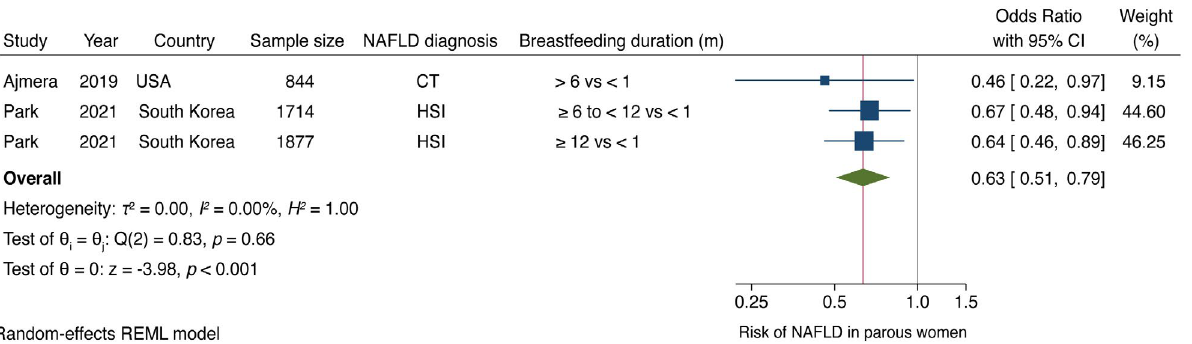
Figure 1 . Forest plots and pool ed estimates of the effects of breastfeeding duration longer than 6 months on the risk of NAFLD (as detected by imaging techniques or indirect biomarkers) in later life of parous women, when compared to the breastfeeding that lasted less than 1 month ( n = 2 studies). Note: regarding the study by Ajmera et al. [4], we have chosen the adjusted odds ratio reported in the model 8. The result, however, remained substantially similar when the odds ratios of the other adjusted models were taken. CT: computed tomography; HSI: hepatic steatosis